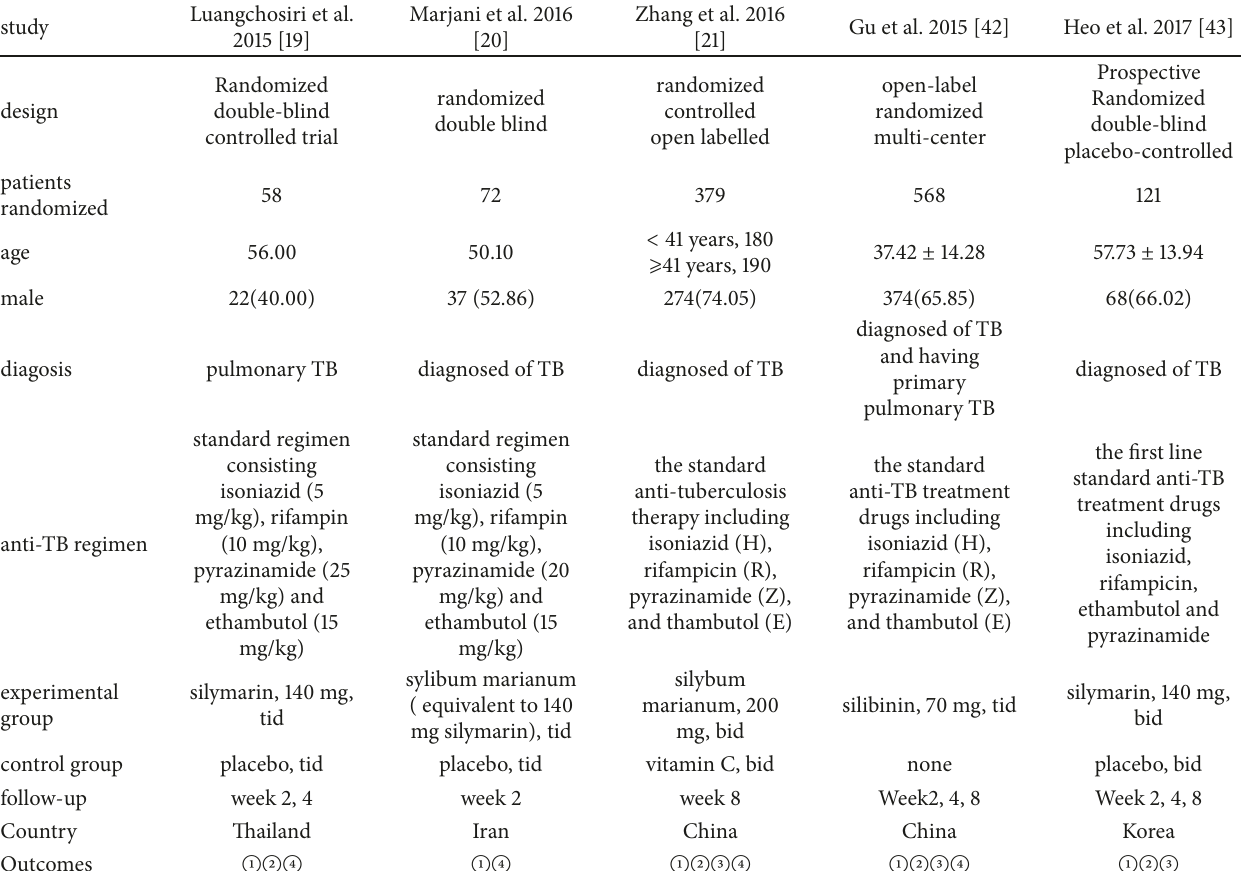
Table 1: Baseline characteristics of the trials included in the meta-analysis.